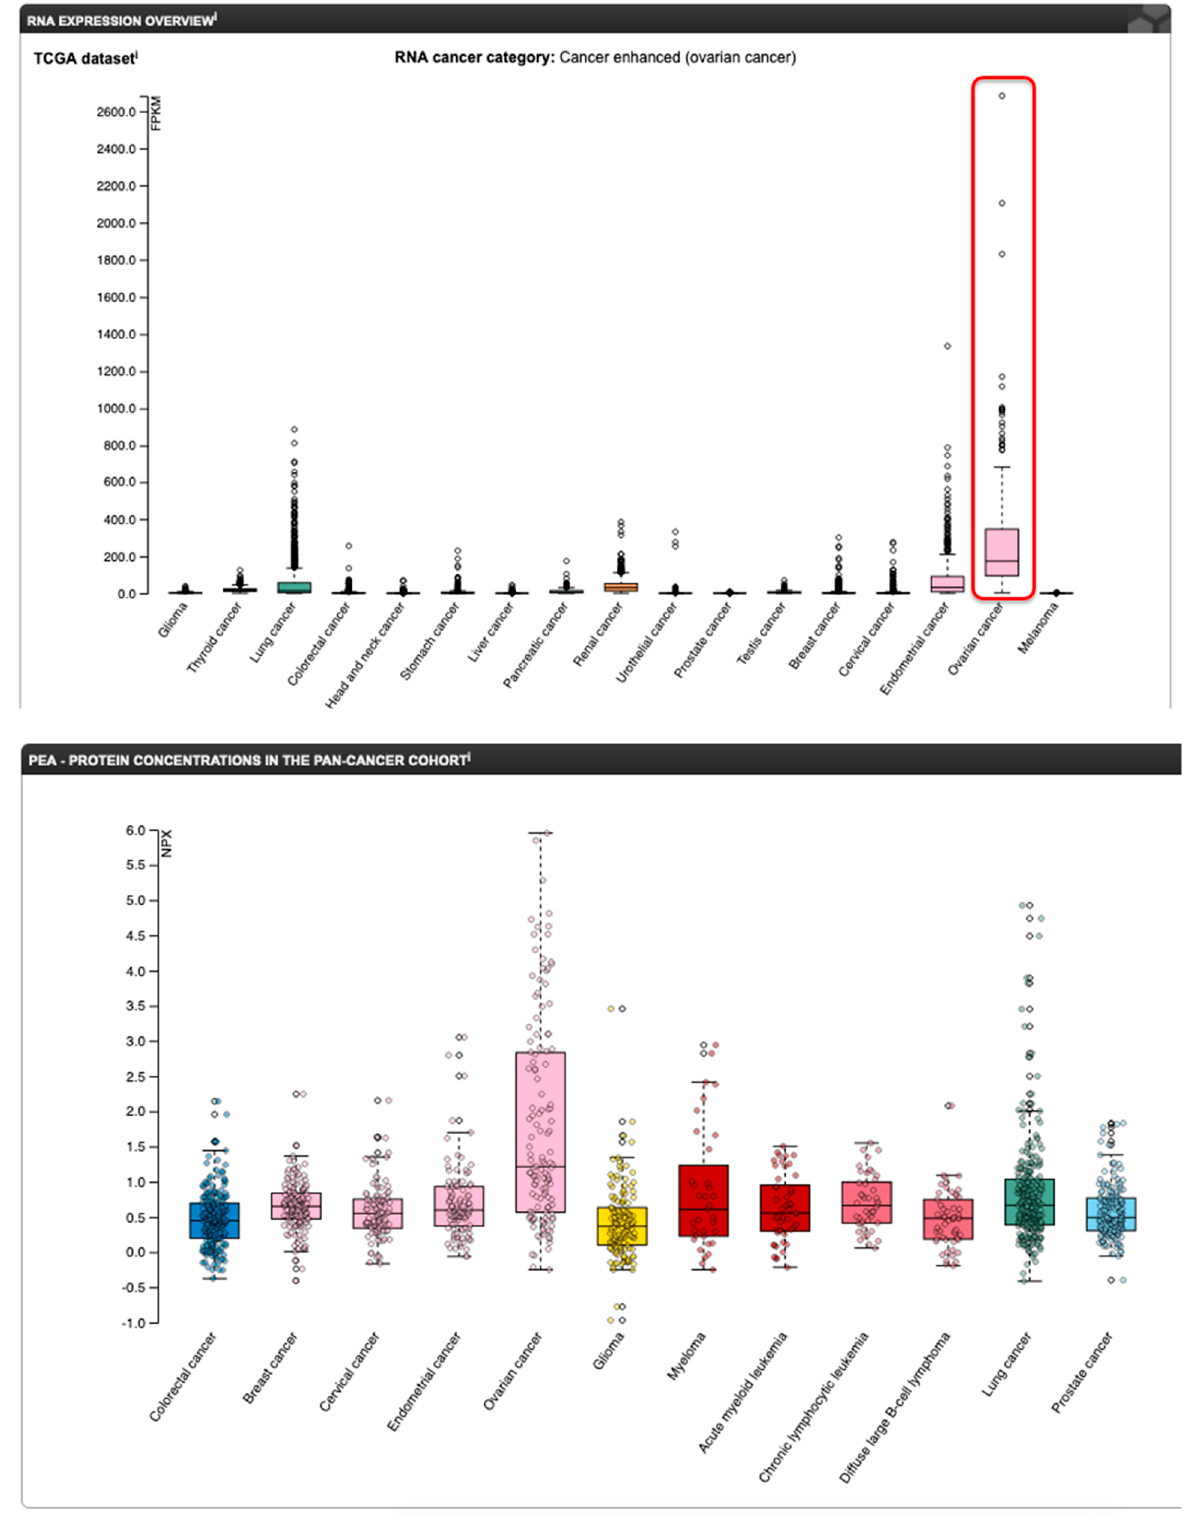
Figure 14. mRNA (top panel) and protein (bottom panel) expression profile of FOLR1 in various cancers (www.proteinatlas.org (accessed on 17 February 2023)). The red rectangle on the mRNA panel highlights the ovarian cancer samples.